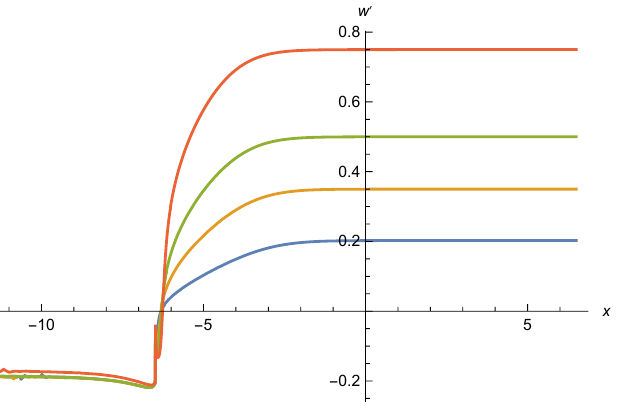
Figure 15. Nonminimal scalar coupling w (cid:48) as function of x = ln ˜ ρ . Parameters and color coding are the same as for Figure 13. The value ξ ∞ = 2 w (cid:48) ( x → ∞ ) can be read off